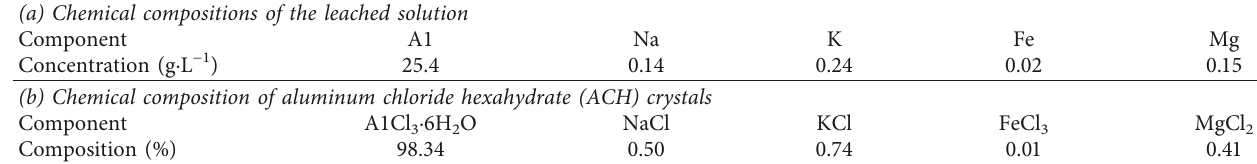
Table 6: Chemical compositions of the leached solution and aluminum chloride hexahydrate crystals.